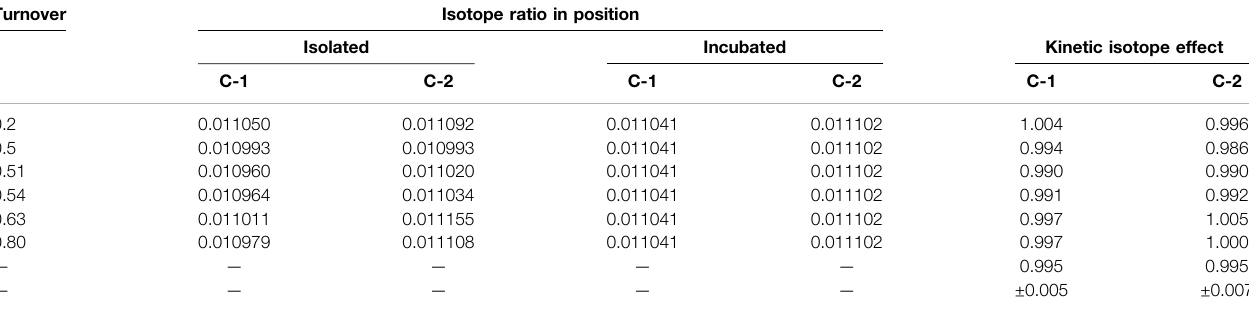
TABLE 3 | Isotope ratio of position C-1 and C-2 in serine before and after incubation with SHMT and calculated kinetic isotope effect on the reaction. Isotope ratios of the isolated products were linear corrected for the isotope effect of the separation step. Turnover Isotope ratio in position